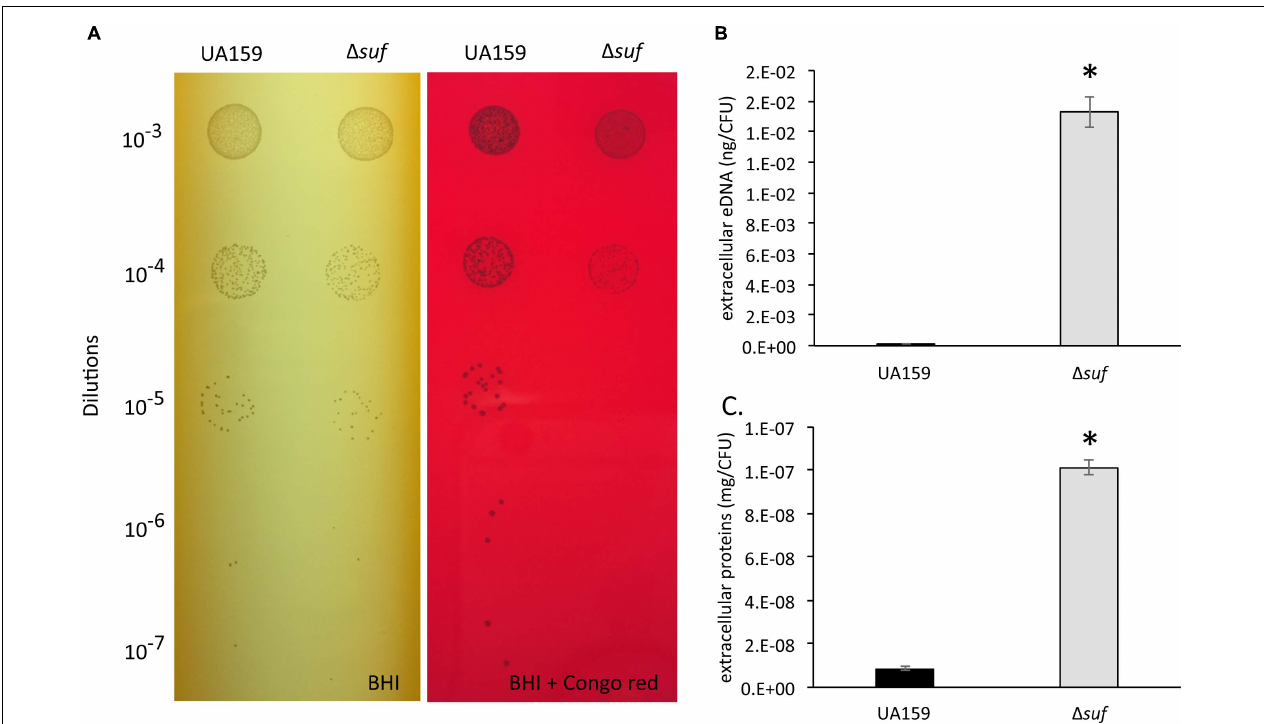
FIGURE 7 | Congo Red sensitivity assay, extracellular DNA and extracellular protein analysis. (A) Resistance to Congo Red has been attributed to the integrity of the cell wall. The growth of Streptococcus mutans wild-type, UA159 and the (cid:49) suf::kan r mutant ( (cid:49) suf ) was evaluated on agar plates containing Congo Red with (cid:49) suf::kan r showing reduced resistance when compared to its parent strain, UA159. The extracellular DNA concentrations (B) and the extracellular protein concentrations (C) of the wild-type and (cid:49) suf::kan r were measured. The values were further normalized using the number of colony-forming units (CFU), and the data represent more than two independent sets of experiments of three replicates each, with * indicating a statistically significant difference at P <